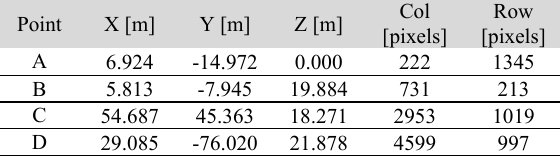
Table 1. Four control points of the first test.